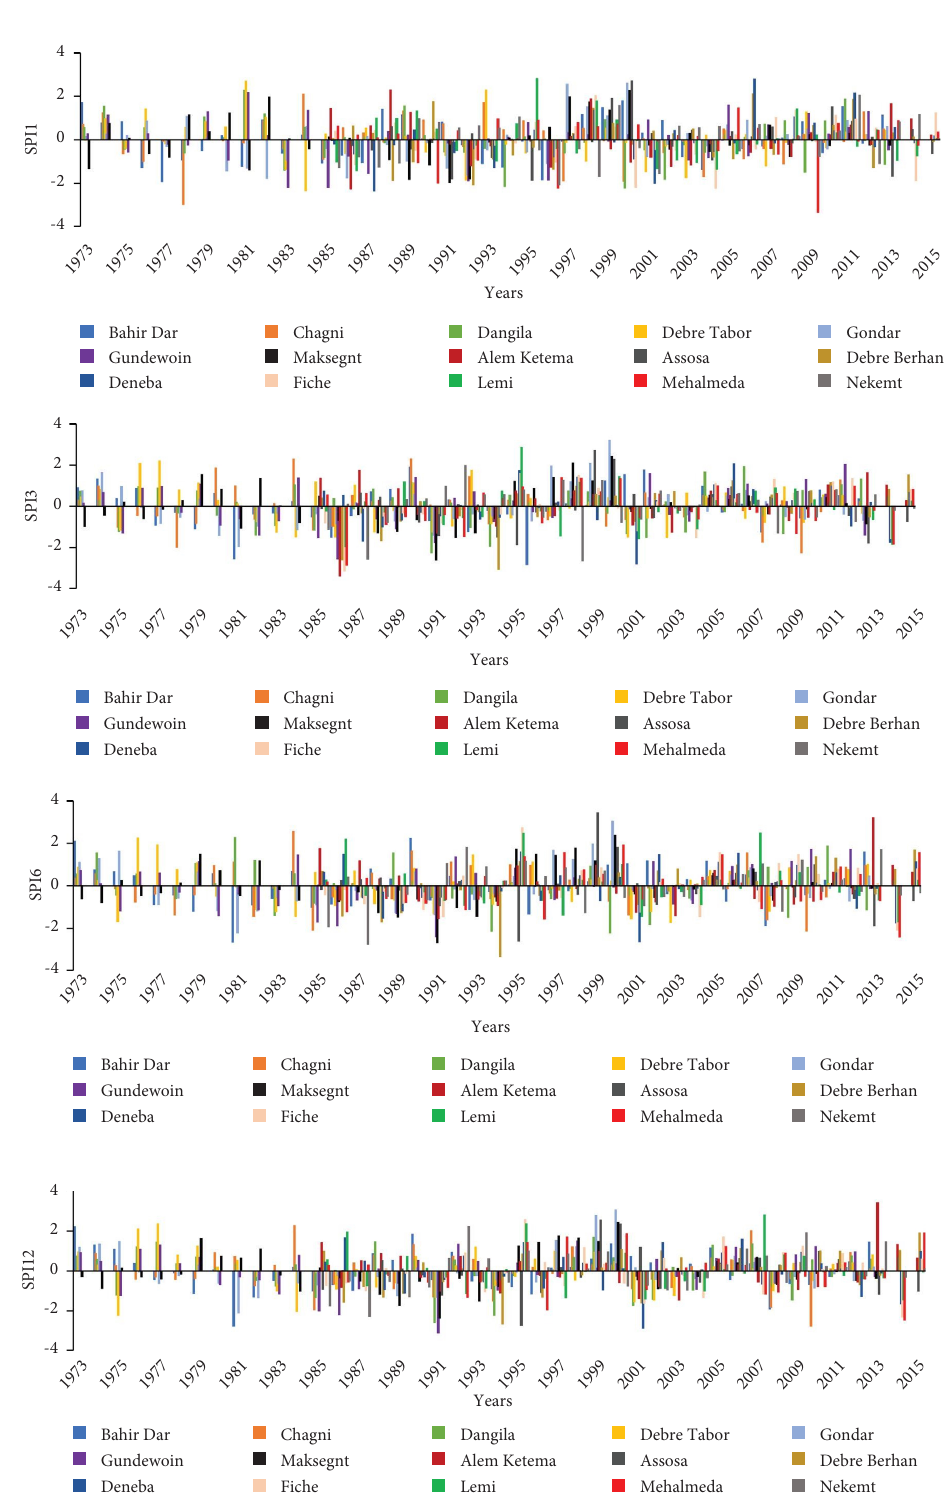
Figure 4: Meteorological drought time series in Abbay river basin using